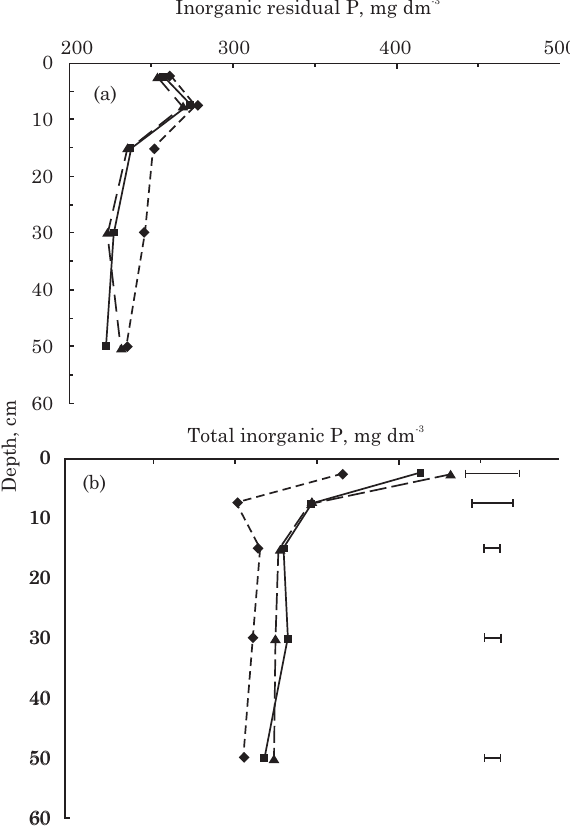
Figure 3. Residual and total inorganic soil P in the soil profile as affected by surface- broadcast P fertilizers. (a) Inorganic residual P; (b) Total inorganic P. Dotted line – No P; dashed line - natural reactive Arad phosphate; solid line – triple superphosphate. Horizontal bars show LSD (P<0.05) and compare treatments within each soil